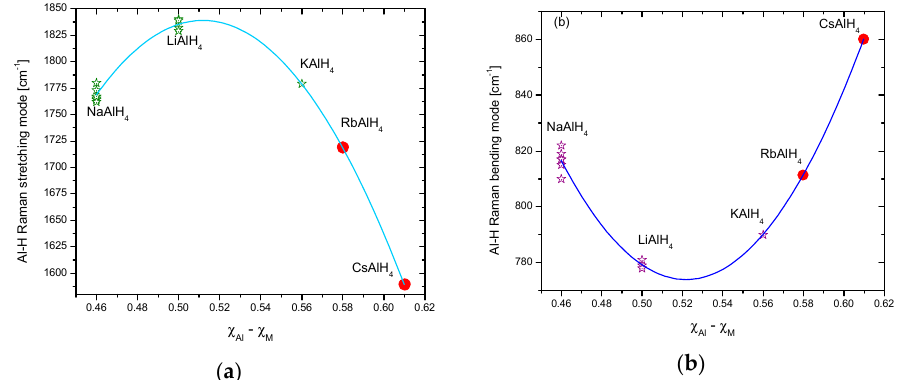
Figure 31. Most intense Raman peak in the group 1 alanates. ( a ) Stretching and ( b ) Bending modes. The red dots are an extrapolation based on the fitted curve. Table 19. Representative infrared frequencies of Al-H bonds reported for different alanates.